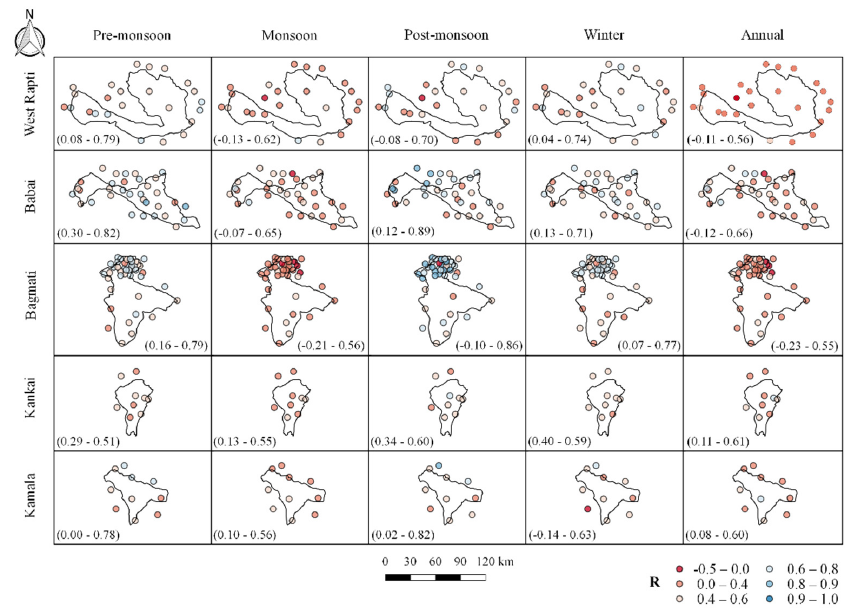
Figure 4. Spatial distributions of R between the CHIRPS product and rain gauge observation at the seasonal and annual scales.